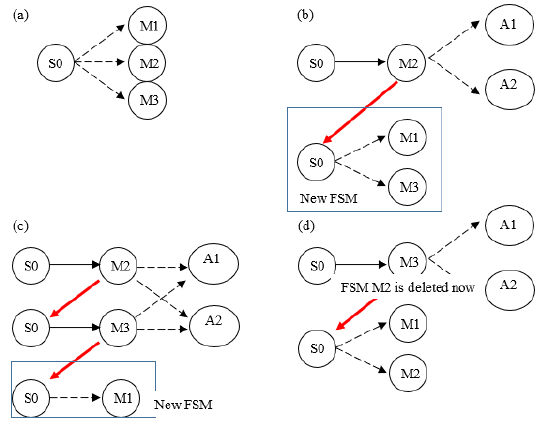
Figure 4. ( a ) An FSM tracking M1 – M3 is initialized; ( b ), ( c ) new FSMs spawned when other intermediate attack types are encountered; ( d ) the FSM tracking M2 is abandoned after packet count t .